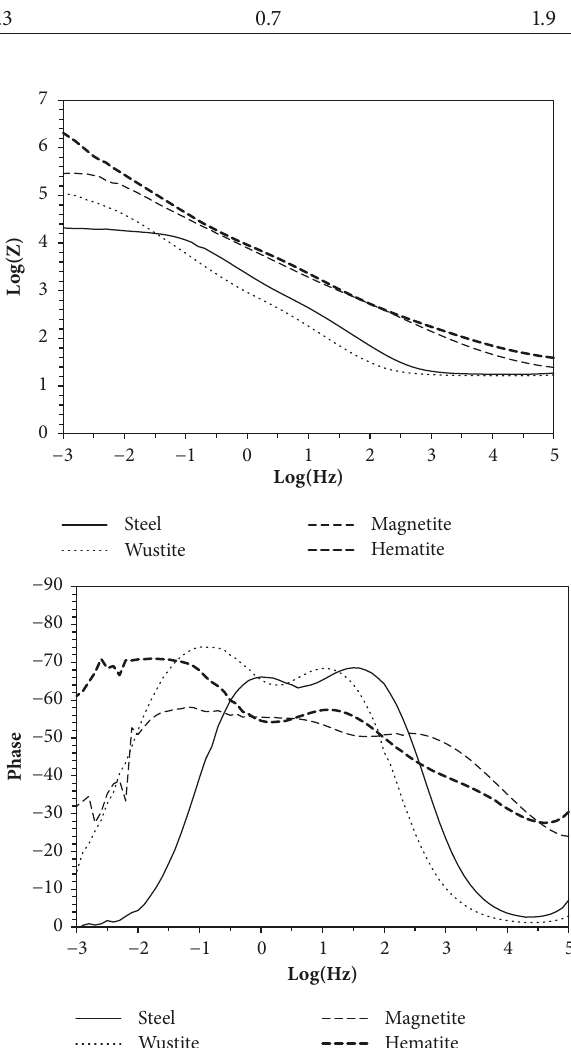
Figure 3: Example of Bode plots obtained in a sat. Calcium hydroxide solution.